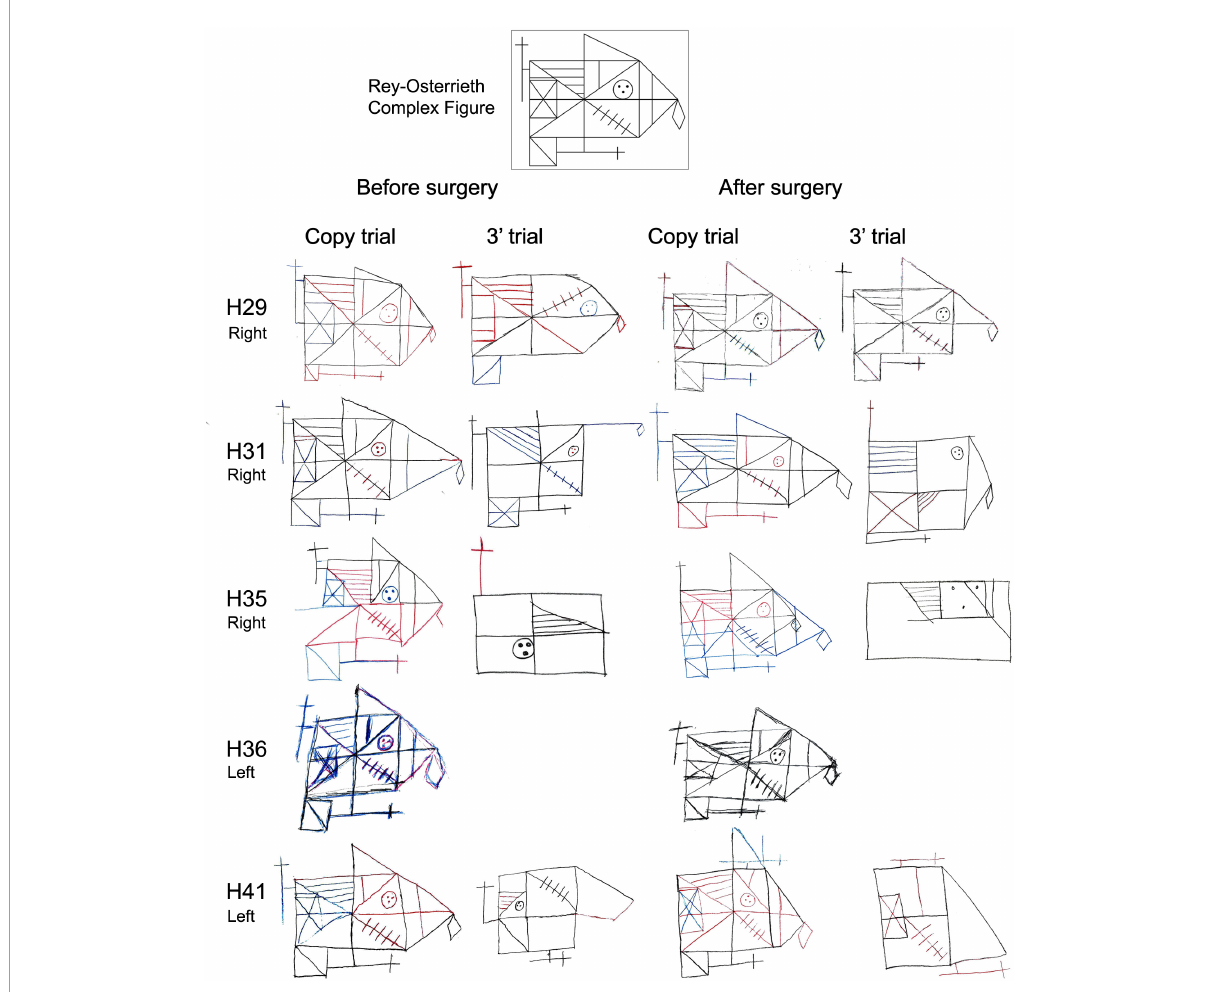
FIGURE5 Before and after surgery ROCF drawings (copy and after 3 (cid:48) trials) from NoHS-patients that became seizure-free after surgery. All patients were right-handed. Patient H36 did not made the 3 (cid:48) trial because, he said, “ I don’t remember ”. The size of the original drawings has not been